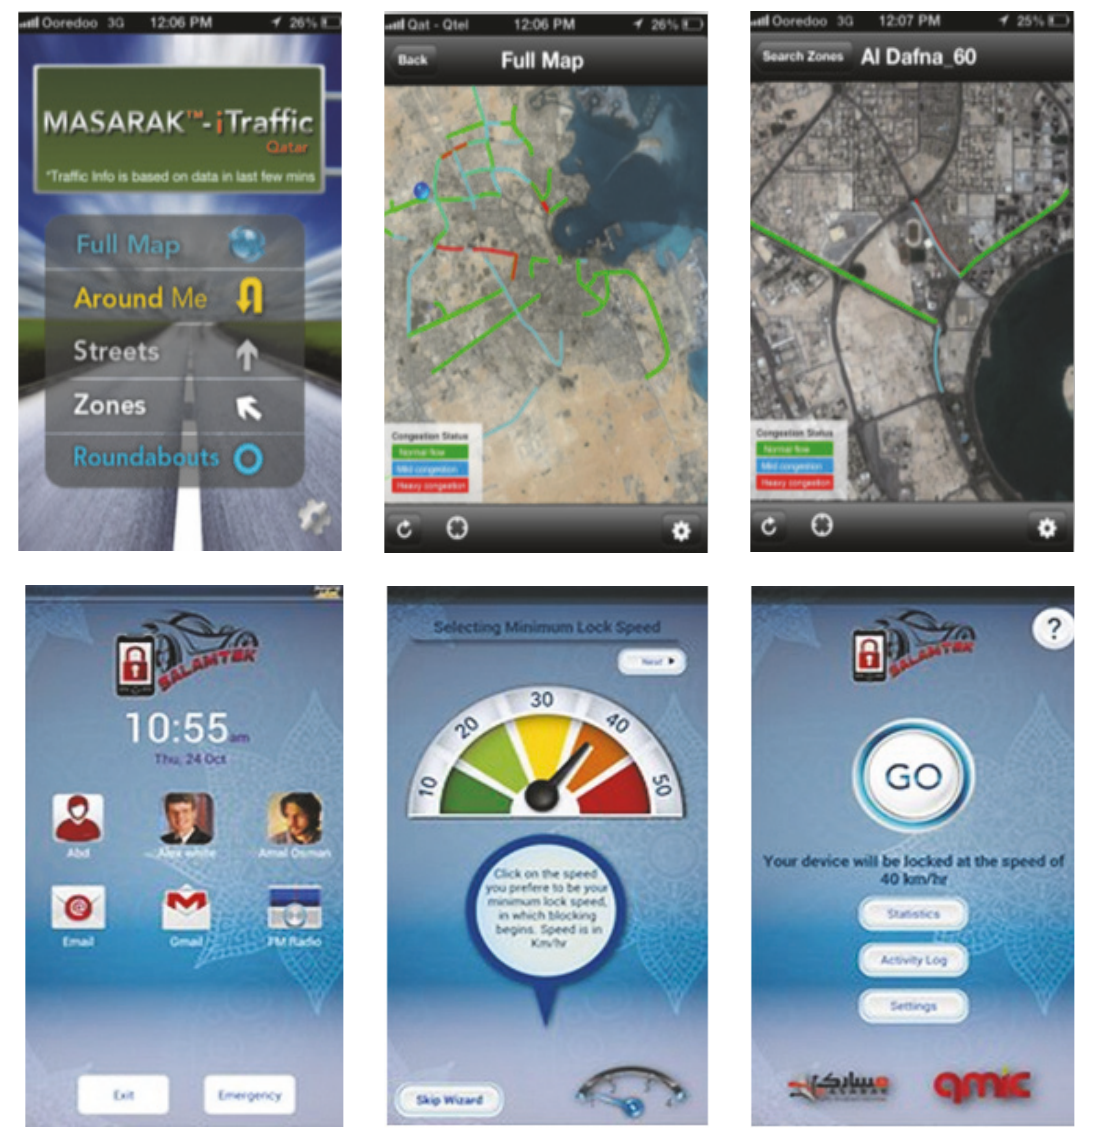
Figure 1: Screenshots of iTraffic (top) and Salamtek (bottom)